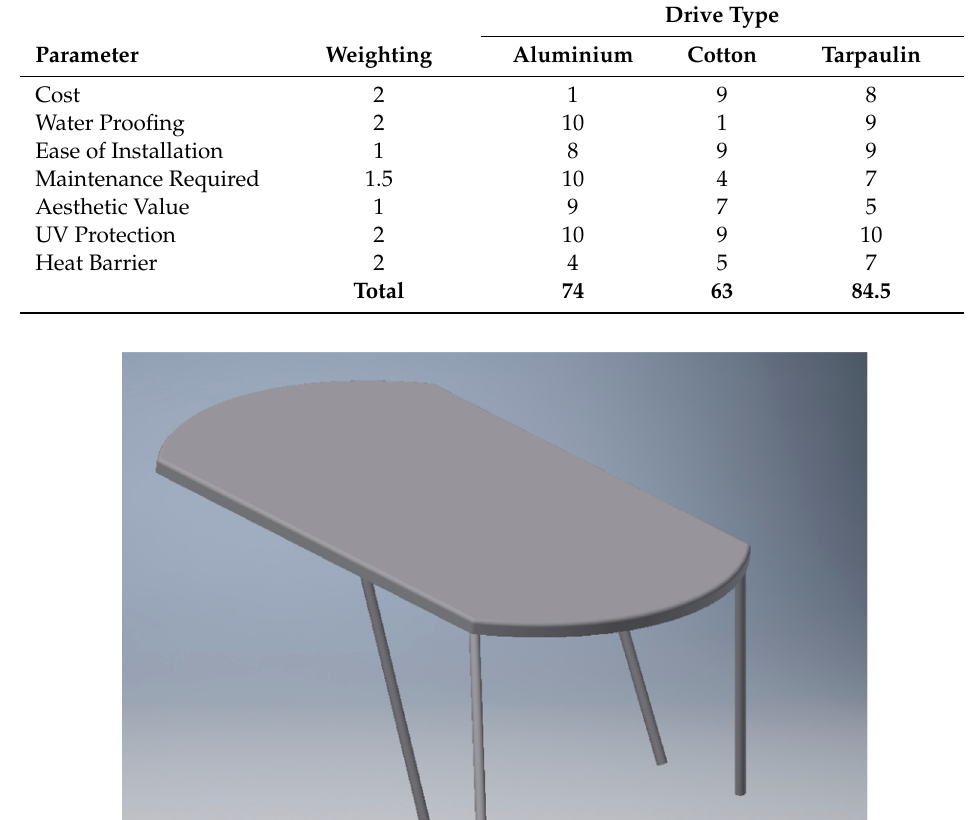
Table 4. Shade material selection matrix.